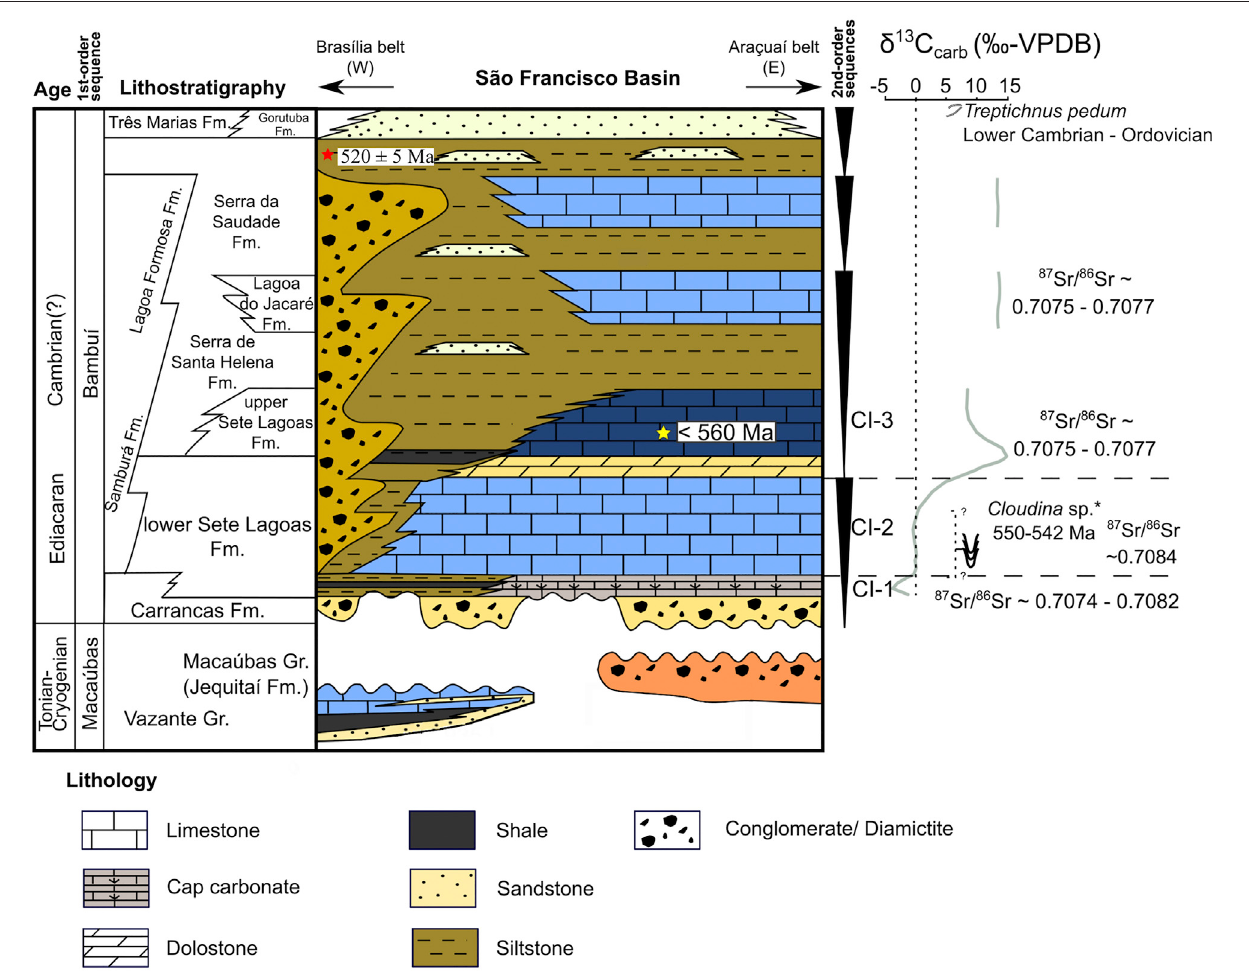
FIGURE 3 | Litho-sequence and chemostratigraphy of the São Francisco Basin. Yellow Star represents maximum depositional age obtained in detrital zircons in the upper Sete Lagoas Formation (Paula-Santos et al., 2015); The red star represents a Serra da Saudade Concordia Age obtained by Moreira et al. (2020). Chemostratigraphic intervals (CIs) were de fi ned by Paula-Santos et al. (2017). Cloudina occurrences are reported in Warren et al. (2014) and Perrella Júnior et al. (2017) and Treptichnus pedum occurrences are reported in Sanchez et al. (2020). Modi fi ed after Caetano-Filho et al. (2019).